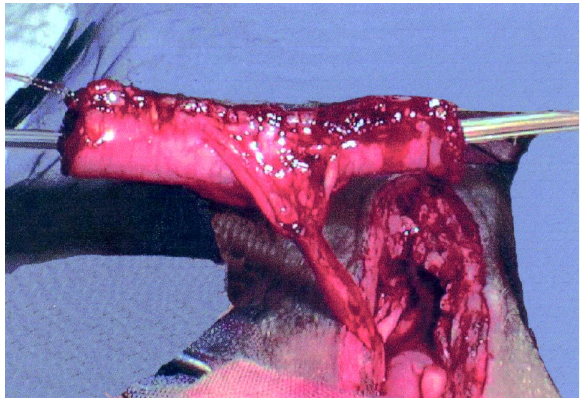
Figure 1 – Re-tubularized jejunal segment before being inserted into the